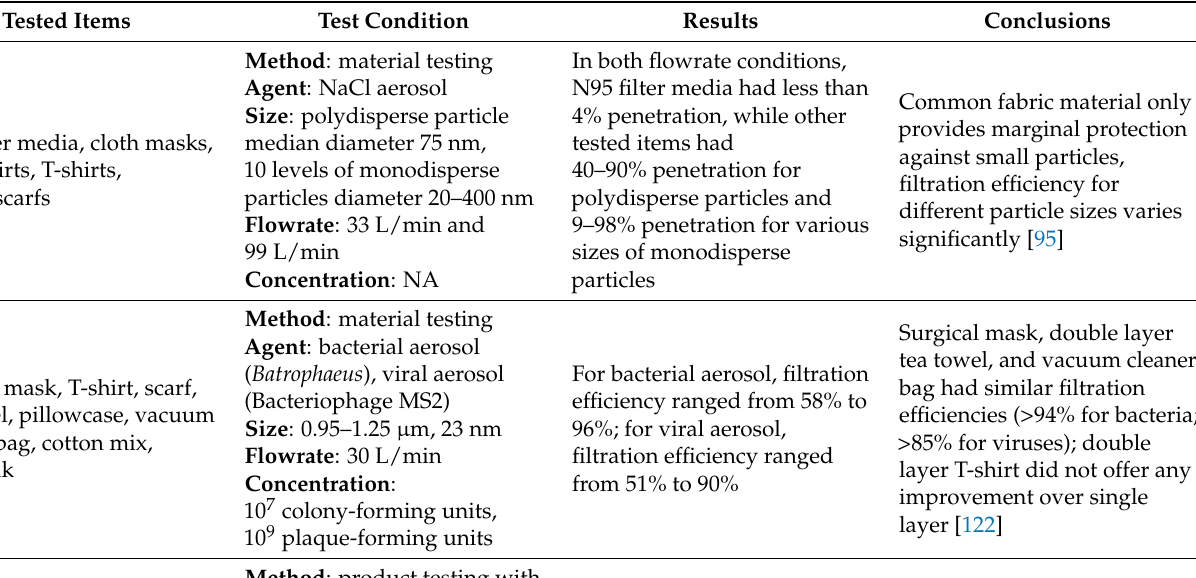
Table 4. Summary of filtration efficiency evaluations of the various materials used to fabricate homemade mask/face coverings. Tested Items Test Condition